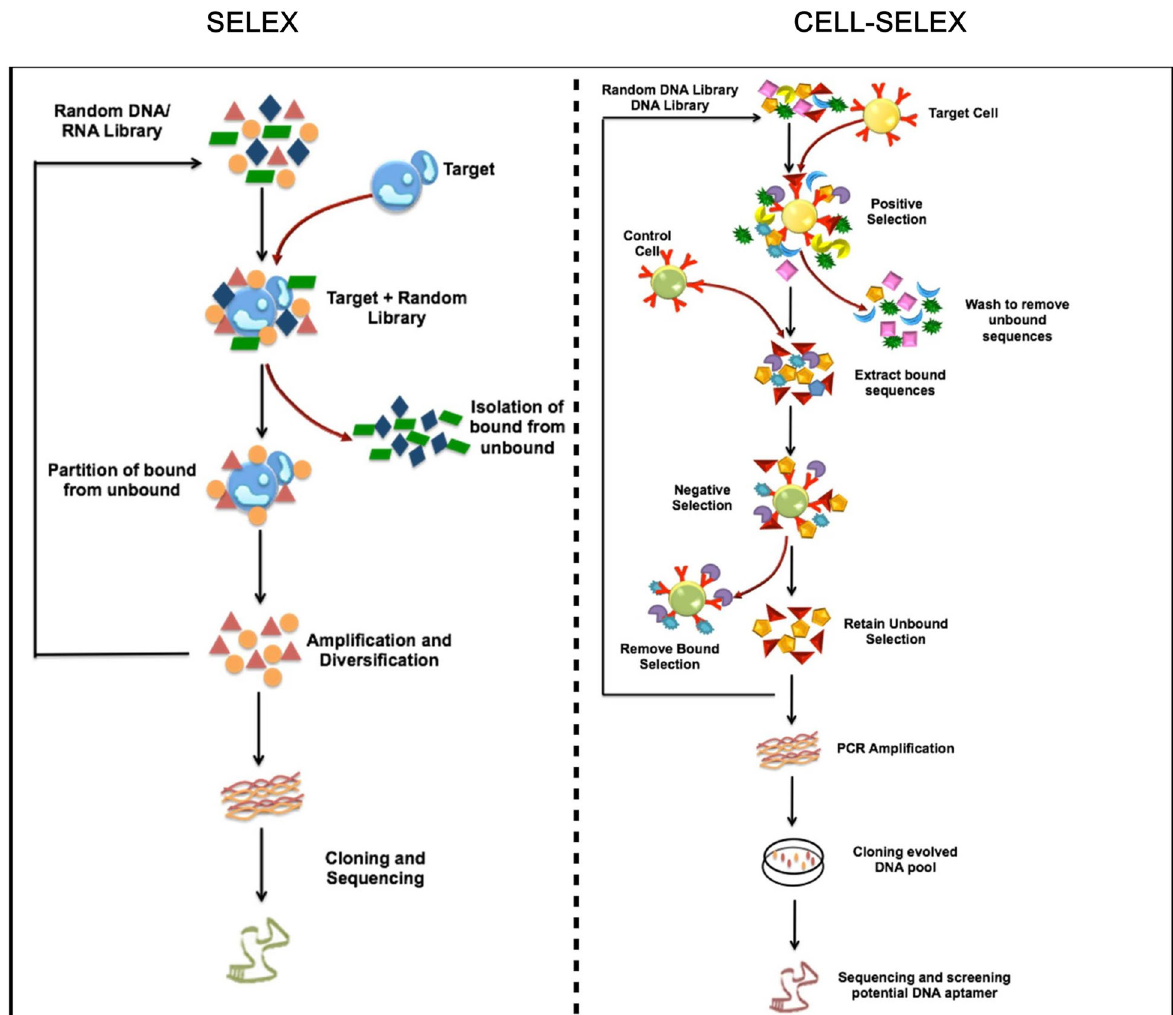
Fig. 3 Selection of aptamers. Schematic representation of aptamer generation by SELEX and